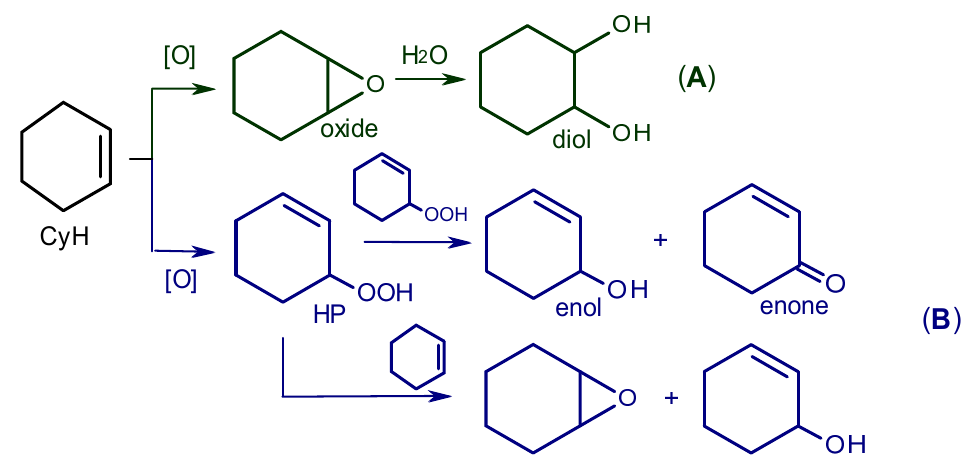
Scheme 1. Cyclohexene oxidation pathways: ( A ) heterolytic (with metal-peroxo species) giving primarily epoxide-relevant products and ( B ) homolytic (radical-mediated) with mostly allylic oxidation products. Recently, it has been reported that in situ addition of a source of protons to various Zr-MOF catalysts is a useful tool to increase the oxidation rate and reduce of the yield of allylic oxidation products in the CyH oxidation with H 2 O 2 [53,86]. Indeed, the Table 2. Cyclohexene oxidation with H 2 O 2 in the presence of various Zr-Si catalysts a .